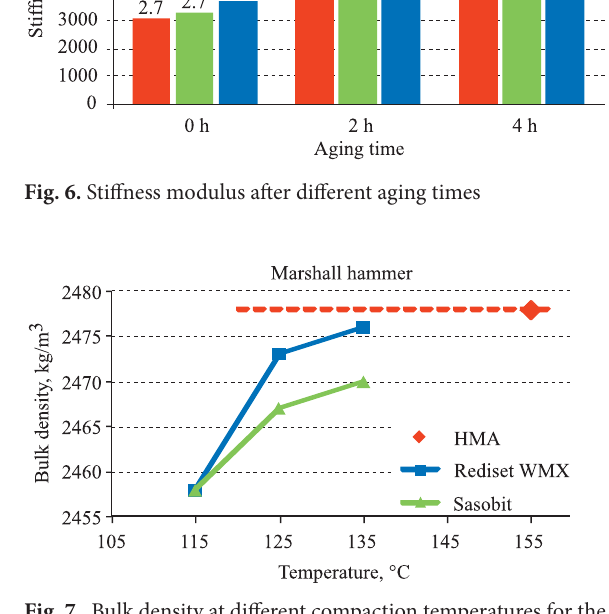
Fig. 7. Bulk density at different compaction temperatures for the Marshall specimens